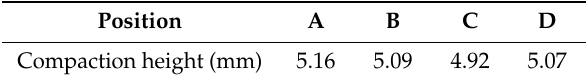
Table 5. Compaction height of the RSCT